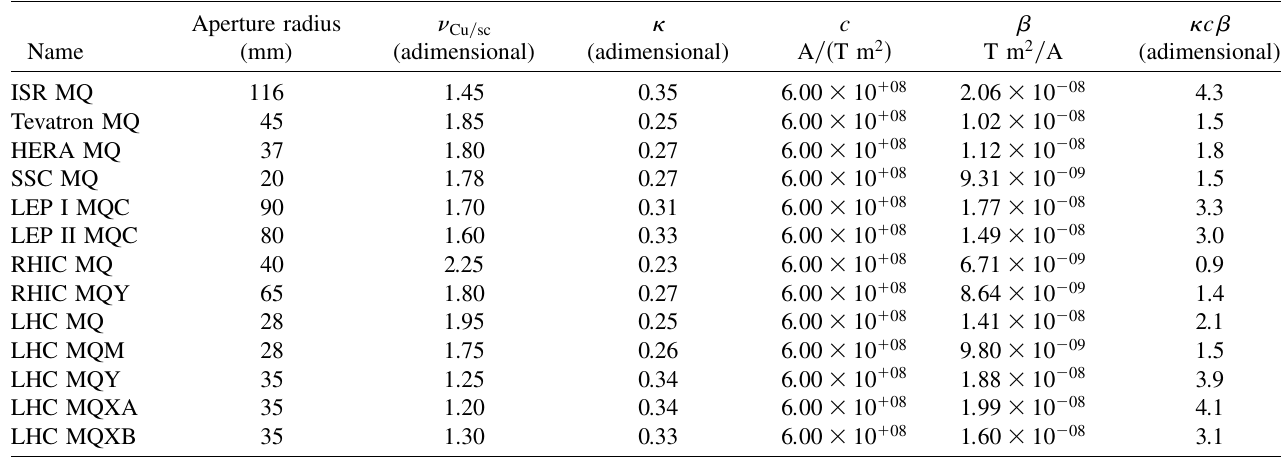
TABLE I. Factor (cid:3)c(cid:5) for some superconducting magnets. Aperture